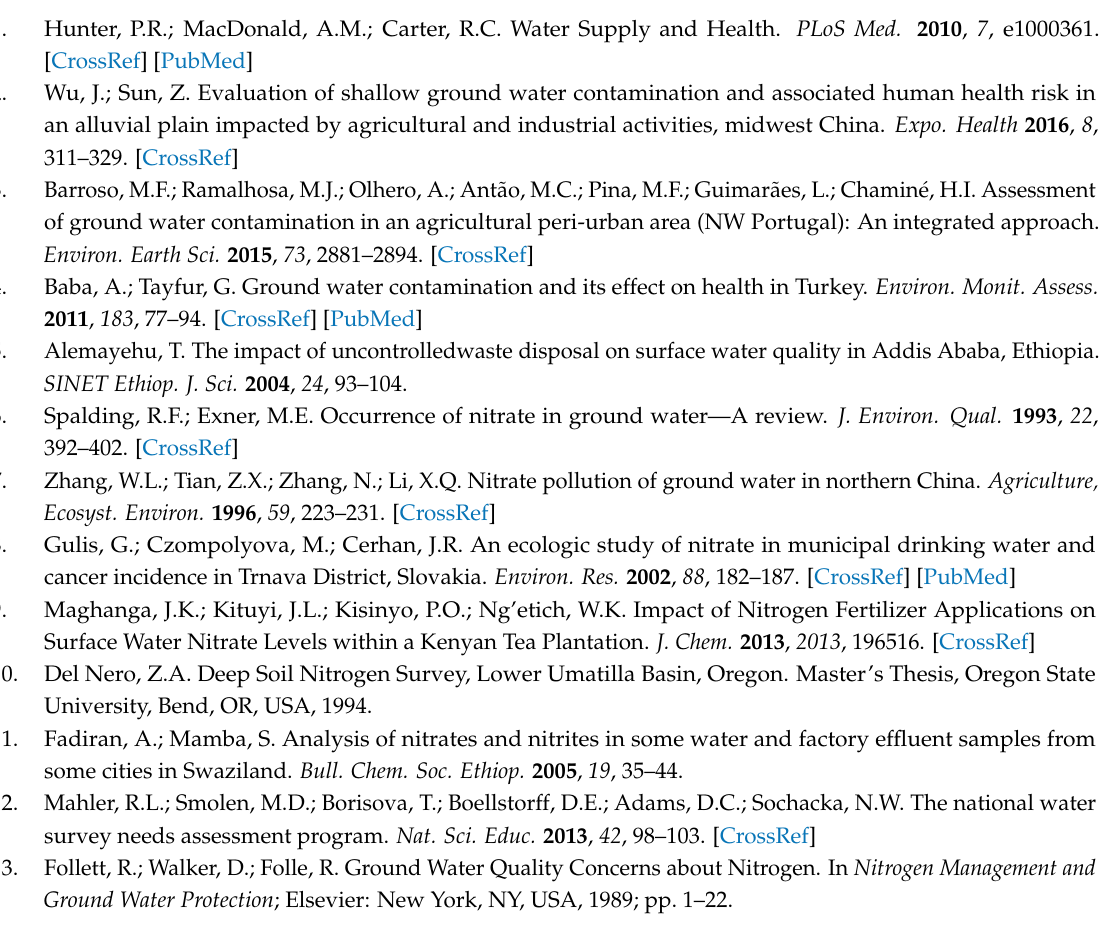
Figure S1: Boxplots of the nitrate concentrations in groundwater measured in developed springs and wells at three hillslope positions and land use in the waterpoint drinking area in South Gondar Zone from December 2013 to June 2014. Table S1: Number of water points sampled each month in the four woredas in South Gondar,